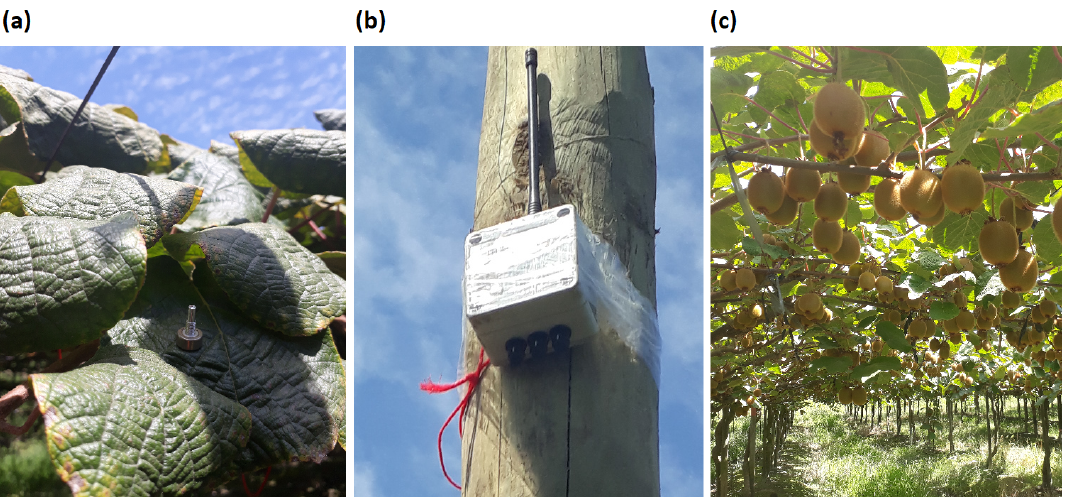
Figure 3. ( a ) Yara Water Sensors installed in the field. ( b ) Transmitter that receives the signal from the Yara Water Sensors installed on each leaf of the tree. ( c ) Foliage of the kiwi crop.